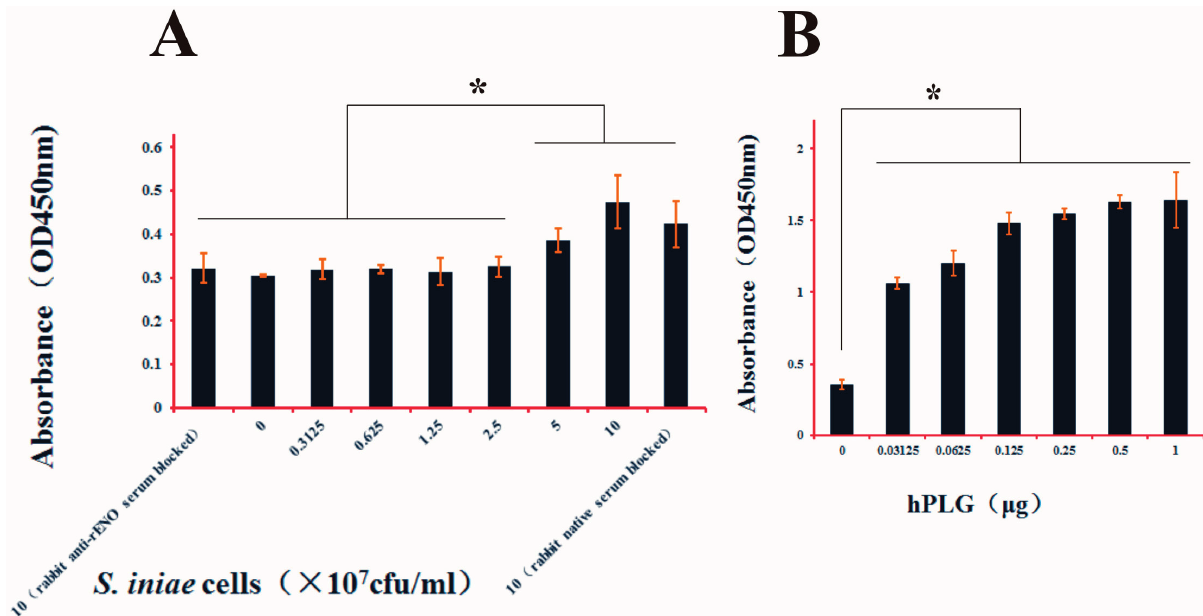
Figure 5. Interaction of human plasminogen with S. iniae whole cells and rENO. ( A ) Different concentration of normal S. iniae cells (0.3125–10 × 10 7 cfu/well) and S. iniae cells (10 × 10 7 cfu/well) were blocked by rabbit anti-rENO serum (1:100) or native rabbit serum (1:100) were coated in plates to demonstrate the interaction of human plasminogen (1 μ g) with α -enolase of the cells surface. The absorbance values of the high concentration of S. iniae cells (5, 10 × 10 7 cfu/well) and native rabbit serum blocked S. iniae cells were significantly higher than other concentration cells and blocked cells ( p < 0.05); ( B ) The rabbit anti-PLGLA ( N -term) IgG (1:1000) was used to analyze the direct interaction of the hPLG (0.03125-1 μ g) and rENO (1 μ g). The binding ability of the rENO to hPLG showed a concentration-dependent increase, and the absorbance values were significant difference compared to the negative control ( p < 0.05). * p < 0.05. NS denotes no statistically significant difference, and error bars indicate